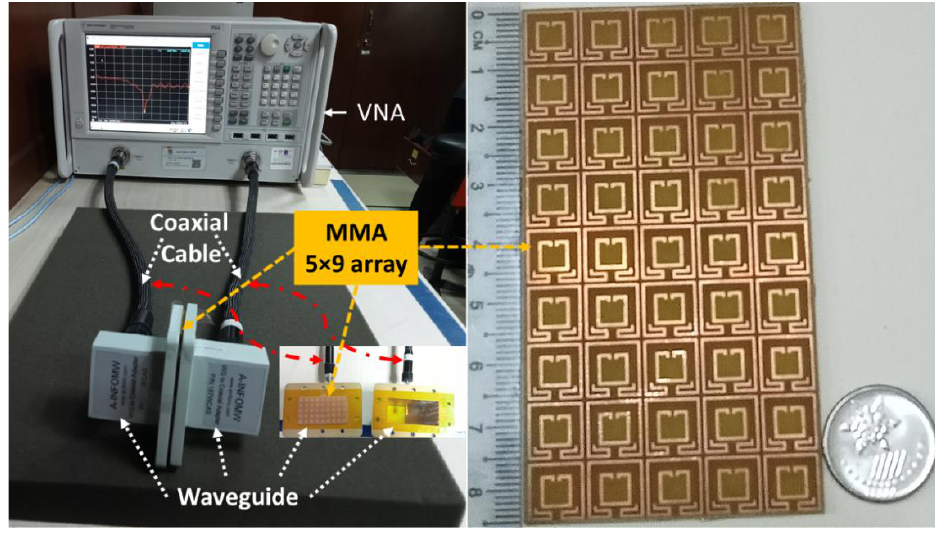
Figure 10. Measurement setup of the proposed MMA.